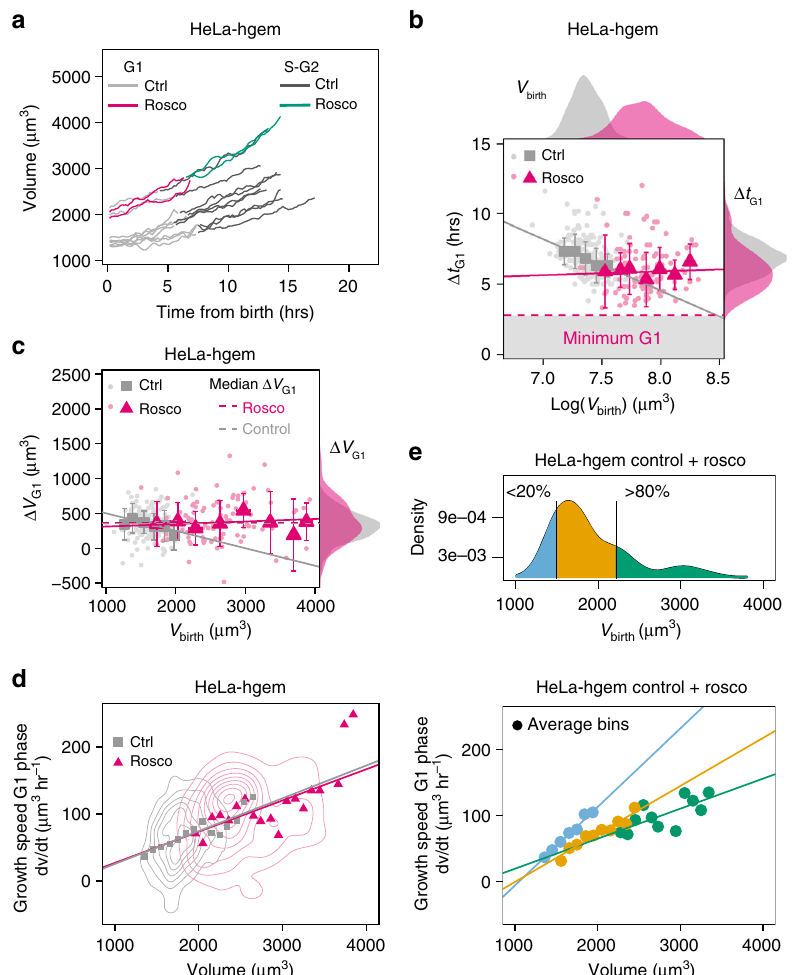
Fig. 6 Size correction by growth-rate modulation in control and abnormal large Hela cells. a Examples of single-cell growth trajectories for HeLa-hgem cells, either control ( ‘ ctrl ’ ), or after washout from Roscovitine treatment ( ‘ rosco ’ ) as a function of time from birth. b Duration of G1, Δ t G1 as a function of the logarithm of volume at birth ( V birth ) for HeLa-hgem cells. Results from the linear fi t: control: a = − 4 ± 0.1, p = 1*10 − 90 , R 2 = 0.888, n = 199, N = 2; Roscovitine: a = 0 ± 0.2, R 2 = 0.019, p = 1, n = 120, N = 3. Red dashed line and gray area are a visual guide for minimum G1 duration. Top: kernel estimates of volume at birth; control: 〈 log V birth 〉 = 7.37, n = 231, N = 2; Roscovitine: 〈 log V birth 〉 = 7.86, n = 136; Welch t test comparing the means: p = 2.2×10 − 16 . Right: kernel estimates of Δ t G1 ; control: 〈 Δ t G1 〉 = 7.0 h., n = 201, N = 2; Roscovitine: 〈 Δ t G1 〉 = 6.1 h, n = 124, N = 3; Welch t test comparing the means: p = 6.5×10 − 7 . c Added volume in G1 ( Δ V fi t: control: a = − 0.25 ± 0.01, p = 1×10 − 46 , R 2 = G1 ) vs. volume at birth for HeLa-hgem cells. Results from the linear 0.706, n = 178, N = 2; Roscovitine (red line): a = 0.1 ± 0.02, p = 0.1, R 2 = 0.046, n = 108, N = 3. Dashed lines represent the median added volume in G1 for the control ( 〈 Δ V G1 〉 = 350 µ m 3 , n = 178) and the Roscovitine ( 〈 Δ V G1 〉 = 390 µ m 3 , n = 108) condition. Right: kernel estimates of Δ V G1 . Welch ’ s t test comparing the mean added volume: p = 0.2423. d Instantaneous growth speed d v /d t in G1 as a function of volume, with bivariate kernel densities (concentric circles) and average bins for control ( n = 119, N = 1) and Roscovitine ( n = 49, N = 2) conditions. Results from the linear fi ts, control: a = 0.0489 ± 0.0005, p ≈ 0, R 2 = 0.78; Roscovitine: a = 0.047 ± 0.002, p = 1×10 − 137 , R 2 = 0.49. e Top: kernel density of volume at birth for control and Roscovitine treated HeLa-hgem cells grouped together. Bars represent the 20 and 80% percentiles and de fi ne three groups: cells within the 0 – 20% percentile (blue), 20 – 80% percentile (orange) and 80 – 100% percentile (green). Bottom: Same data as d but for the three groups analyzed separately. Results from the linear fi ts (lines) on the average bins (dots) for each group with nc (number of control cells) and nr (number of Rocovitine-treated cells): 0 – 20%: a = 0.119 ± 0.008, p = 4.1×10 − 5 , R 2 = 0.98, nc = 24, nr = 0; 20 – 80%: a = 0.072 ± 0.009, p = 4.88×10 − 5 , R 2 = 0.90, nc = 60, nr = 15; 80 – 100%: a = 0.05 ± 0.01, p = 0.00192, R 2 = 0.43, nc = 3, nr = 24. For b – d , control condition ( ‘ ctrl ’ ) is in gray and Roscovitine-treated condition ( ‘ rosco ’ ) is in red. Individual cell measures (dots) as well as median ( c , d ) or average ( d ) bins (ctrl: squares, rosco: triangles) and s.d. (bars) are shown. Solid lines shows linear regression on the bins weighted by the number of event in each bin. a is alsways given as slope ± standard error. See also Supplementary Figures 6 and